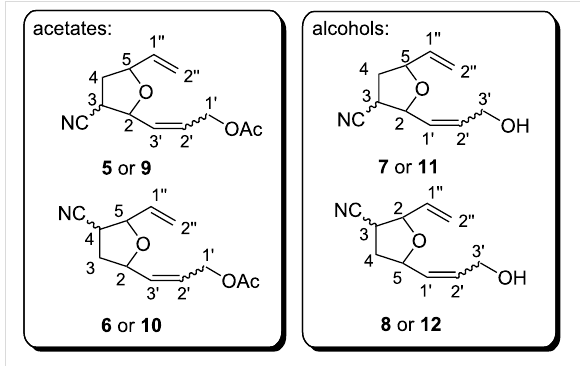
Figure 3: Numbering of carbon atoms in cross metathesis products.